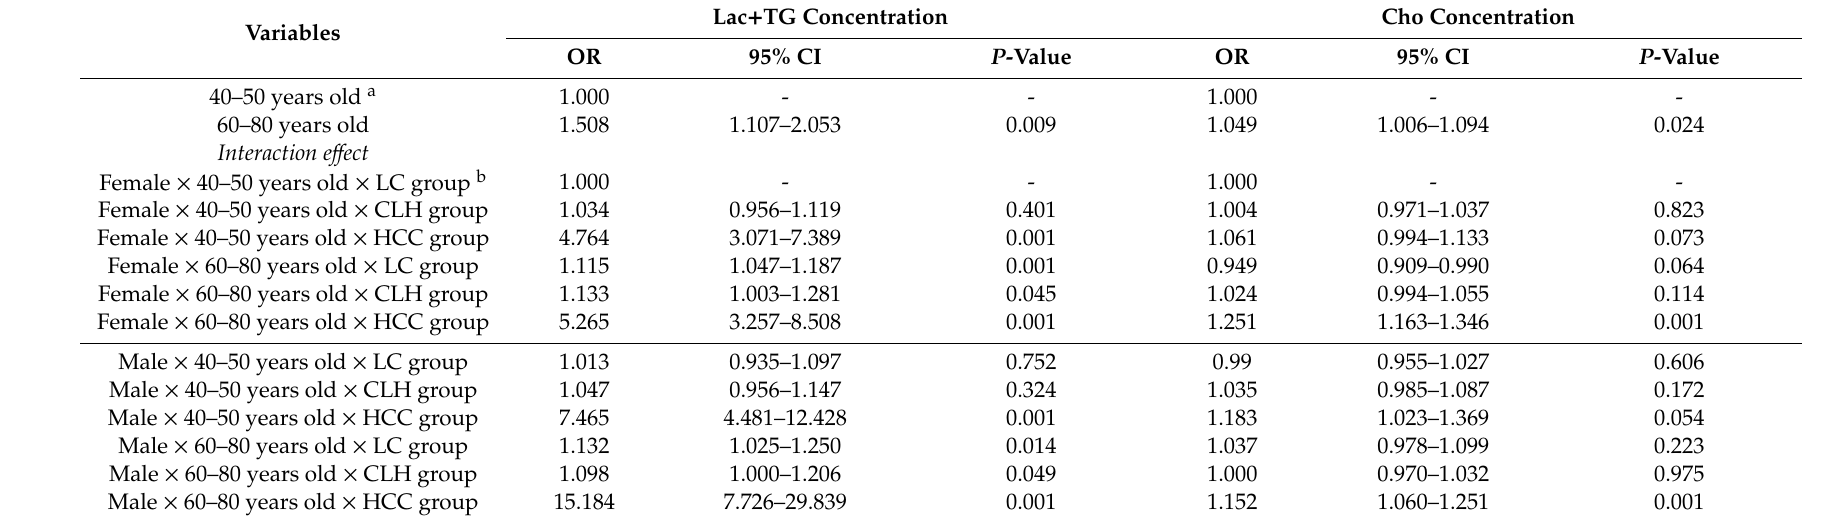
Table 3. GEE analysis for risk factors associated with metabolic changes of Lac + TG and Cho in LC, CLH, and HCC